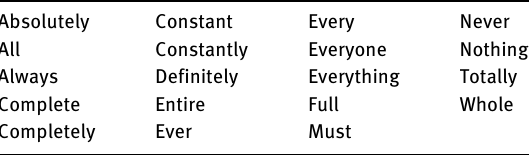
Table 1: Absolutist words validated by Al-Mosaiwi et al.